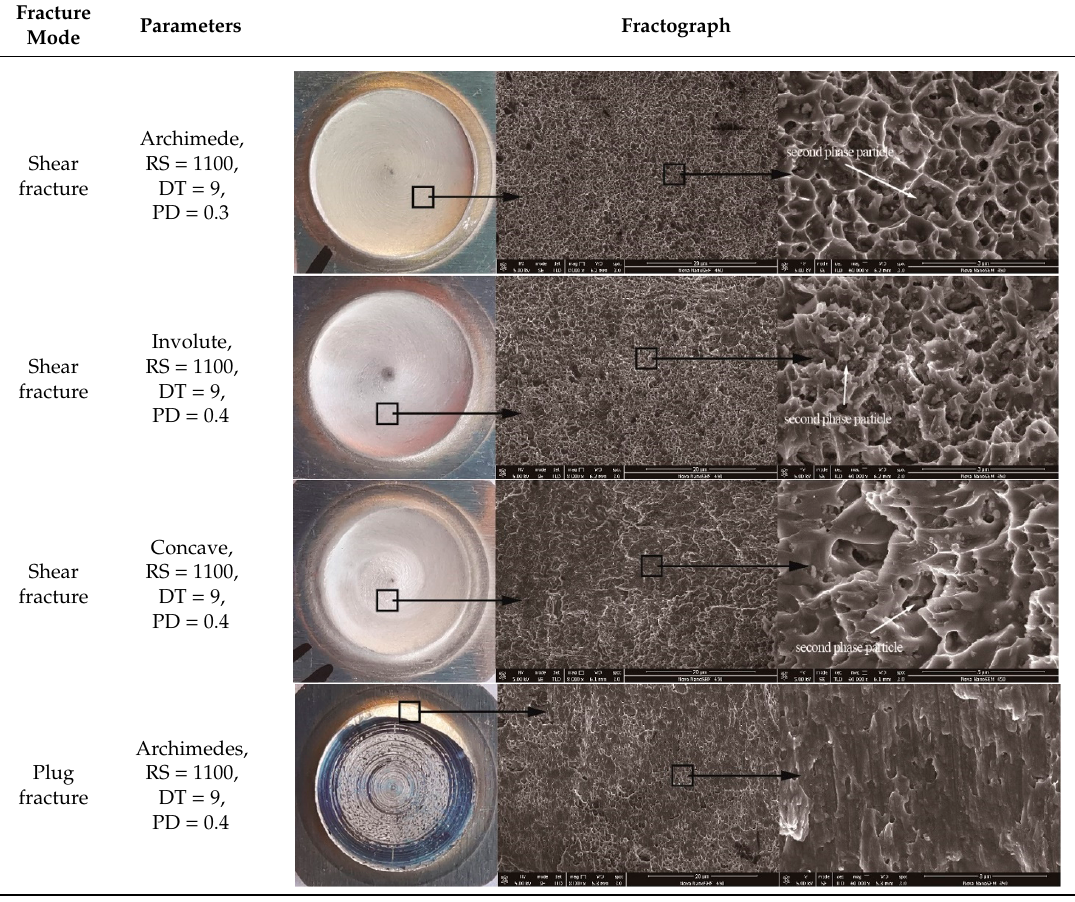
Table 3. Fractographs of the di ff erent facture modes in the bottom sheets.